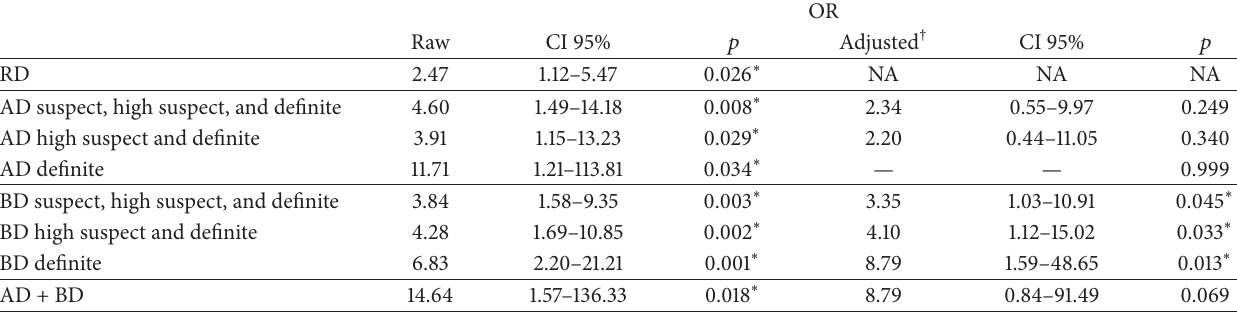
Table 7: Adjusted estimation of the association between visual symptomatology and all diagnosed dysfunctions including the different grades of dysfunctions according to the number of clinical signs used (RD: refractive dysfunction; AD: accommodative dysfunction; BD: binocular dysfunction; CI: confidence